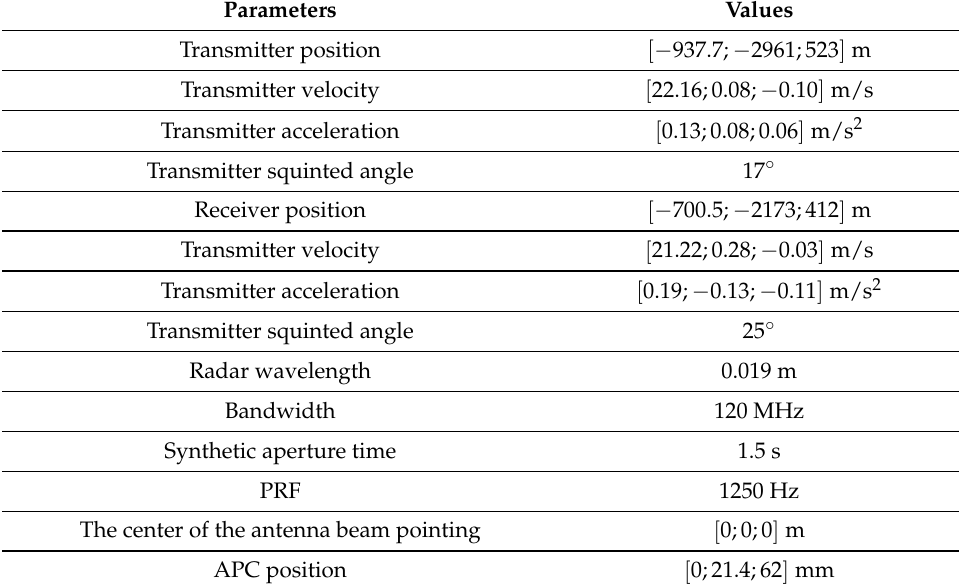
Table 5. Experiment parameters.